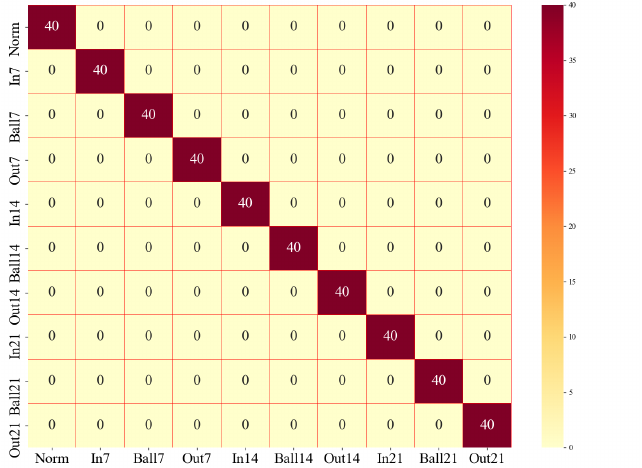
Figure 6. Multi-class confusion matrix of proposed method on CWRU